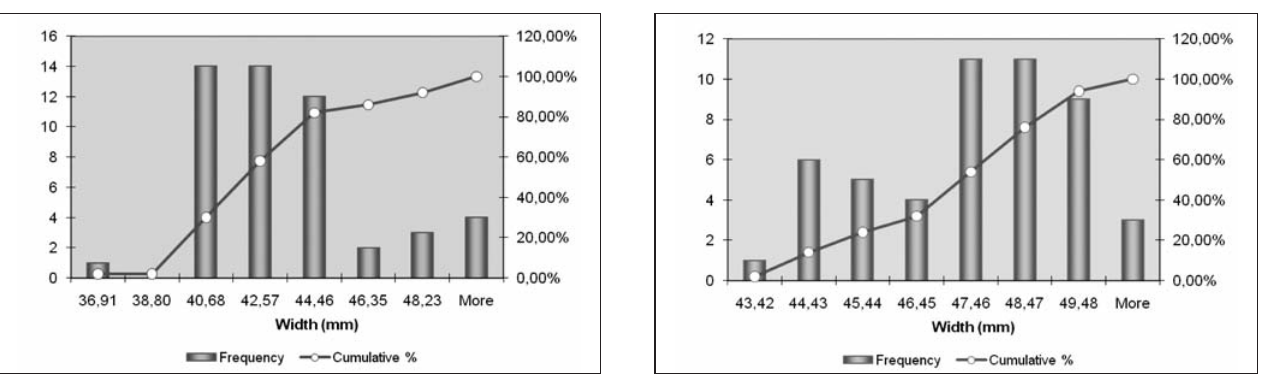
Fig. 16: Distribution of the width values of category AA of Hungarian apricot Table 2. Characteristics of Jumbo